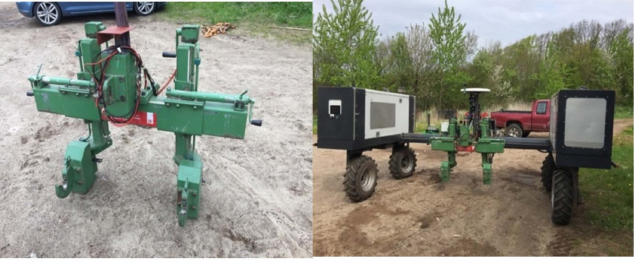
Figure 3. Mounted string gauge on the robot. Two different implementations were mounted on the robot in this pulling test.